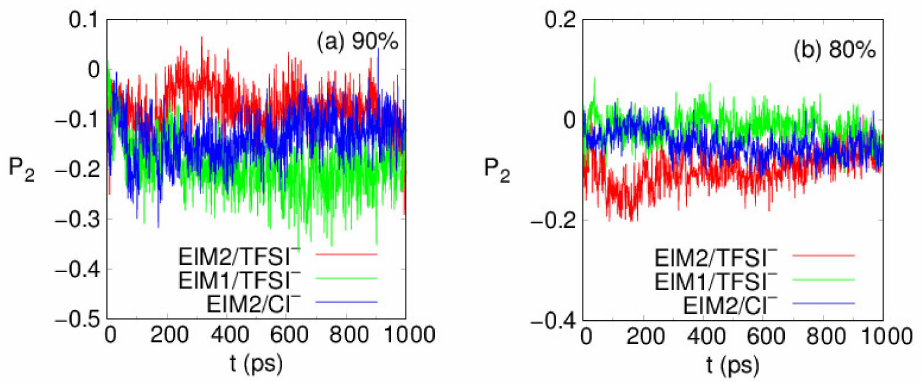
Figure 5. Order parameters P 2 ( cos θ ( t )) of the PILs at ( a ) ϕ = 90 and ( b ) 80% at 300 K, where P 2 is the second order Legendre polynomial and cos θ ( t ) is the angle between the ring orientation and its z -axis of the simulation box at time t .